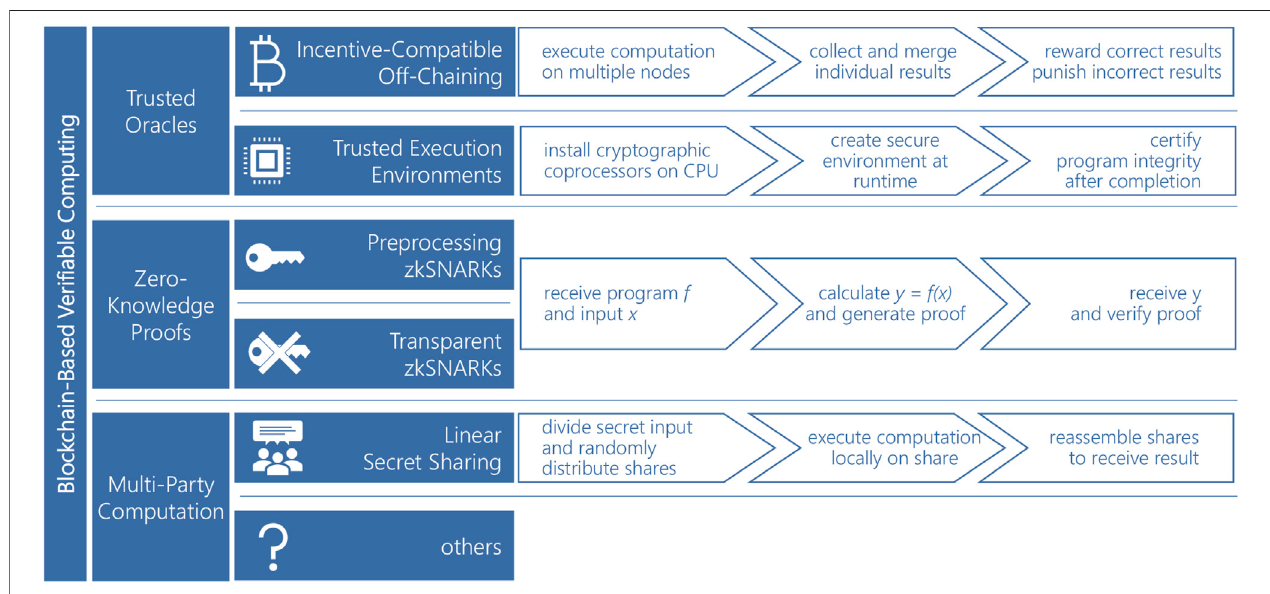
FIGURE 2 | Overview and function of presented veri fi able computing